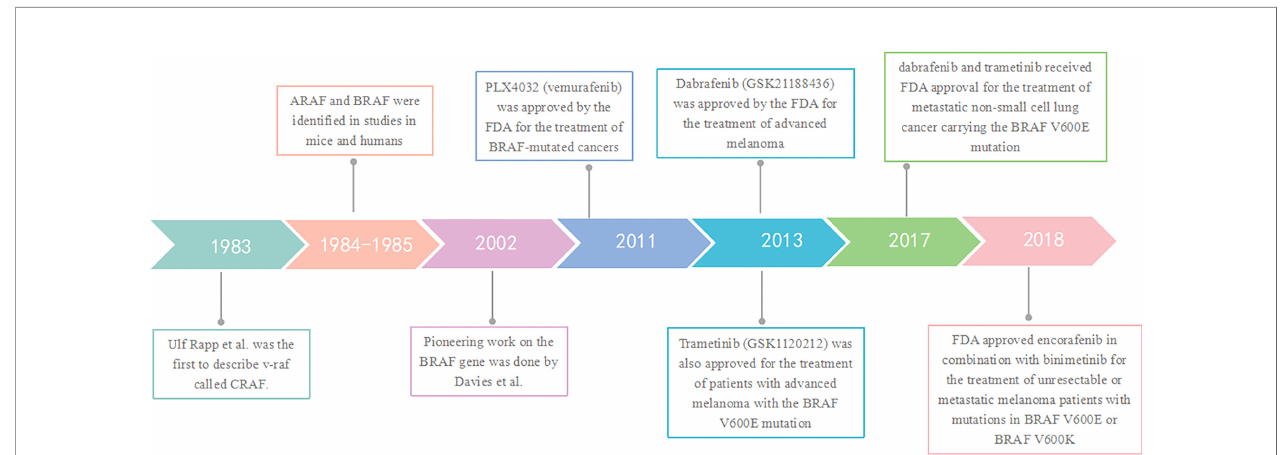
FIGURE 1 | Timeline of key events in BRAF signaling